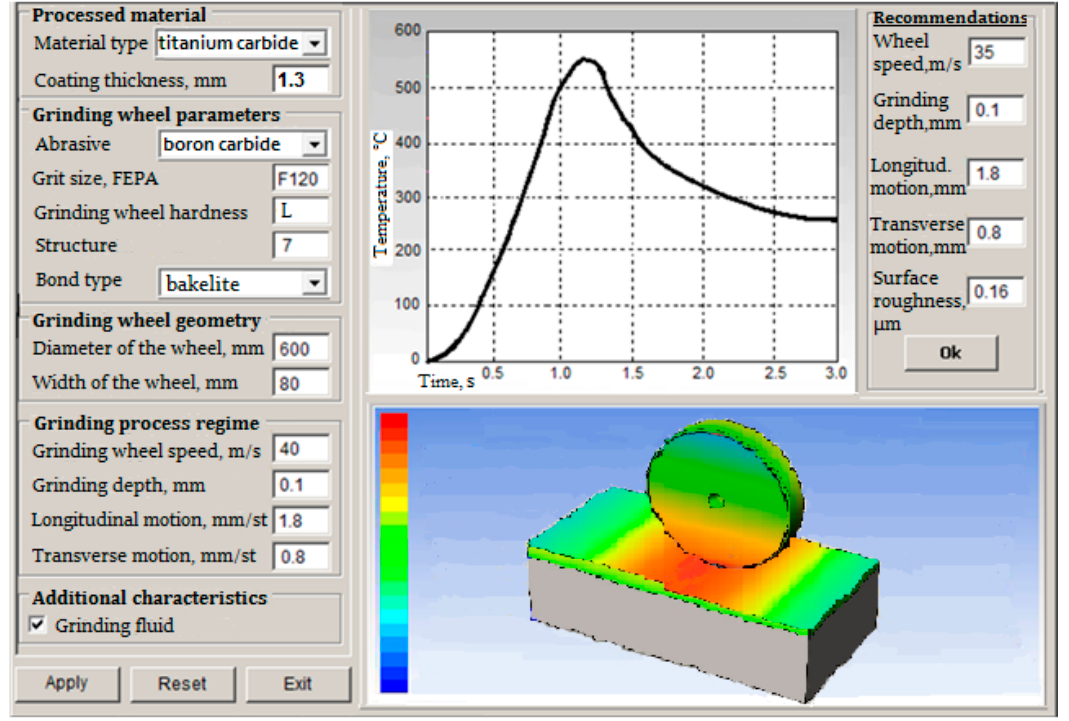
Figure 3. Modelling of the temperature field of the plasma coatings’ grinding process.